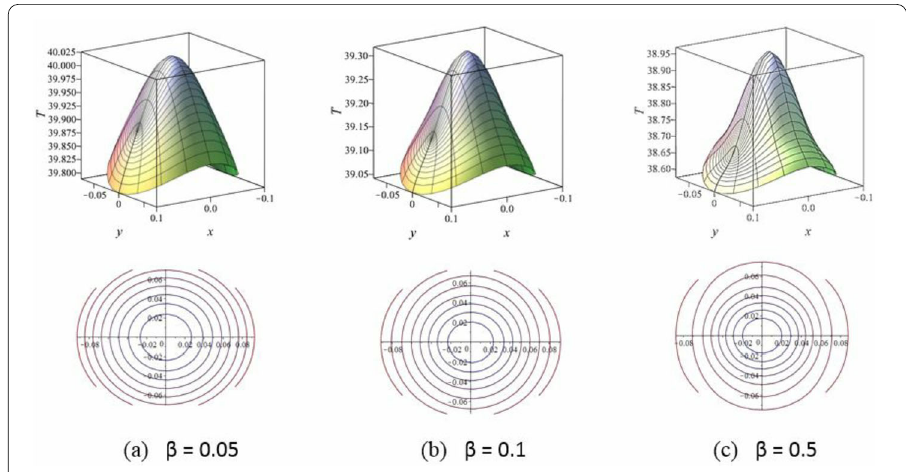
Figure 4 Temperature distribution. Temperature distribution on the cross section z = 5 cm in a full wave cycle at time t = 123 s obtained from the model with various slip lengths of 0.05,0.1,0.5 and semi-axes lengths of a = 0.1 cm and b = 0.075 cm